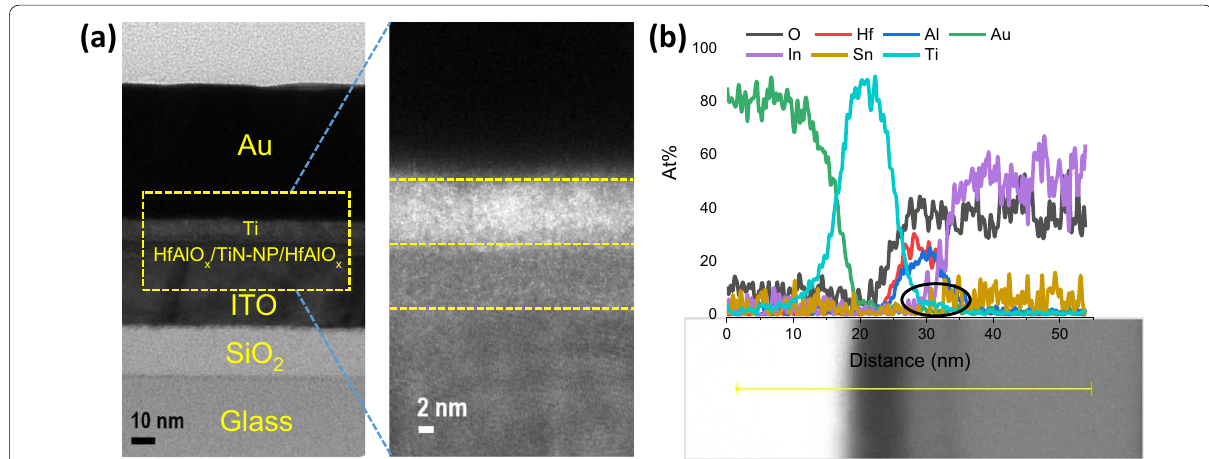
Fig. 1 a Cross-sectional HRTEM of the Au/Ti/HfAlO x /TiN-NP/HfAlO x /ITO RRAM device. Right side magnified switching layer presented. b EDS line profile of the RRAM device measured from Au/Ti top electrode to ITO bottom electrode